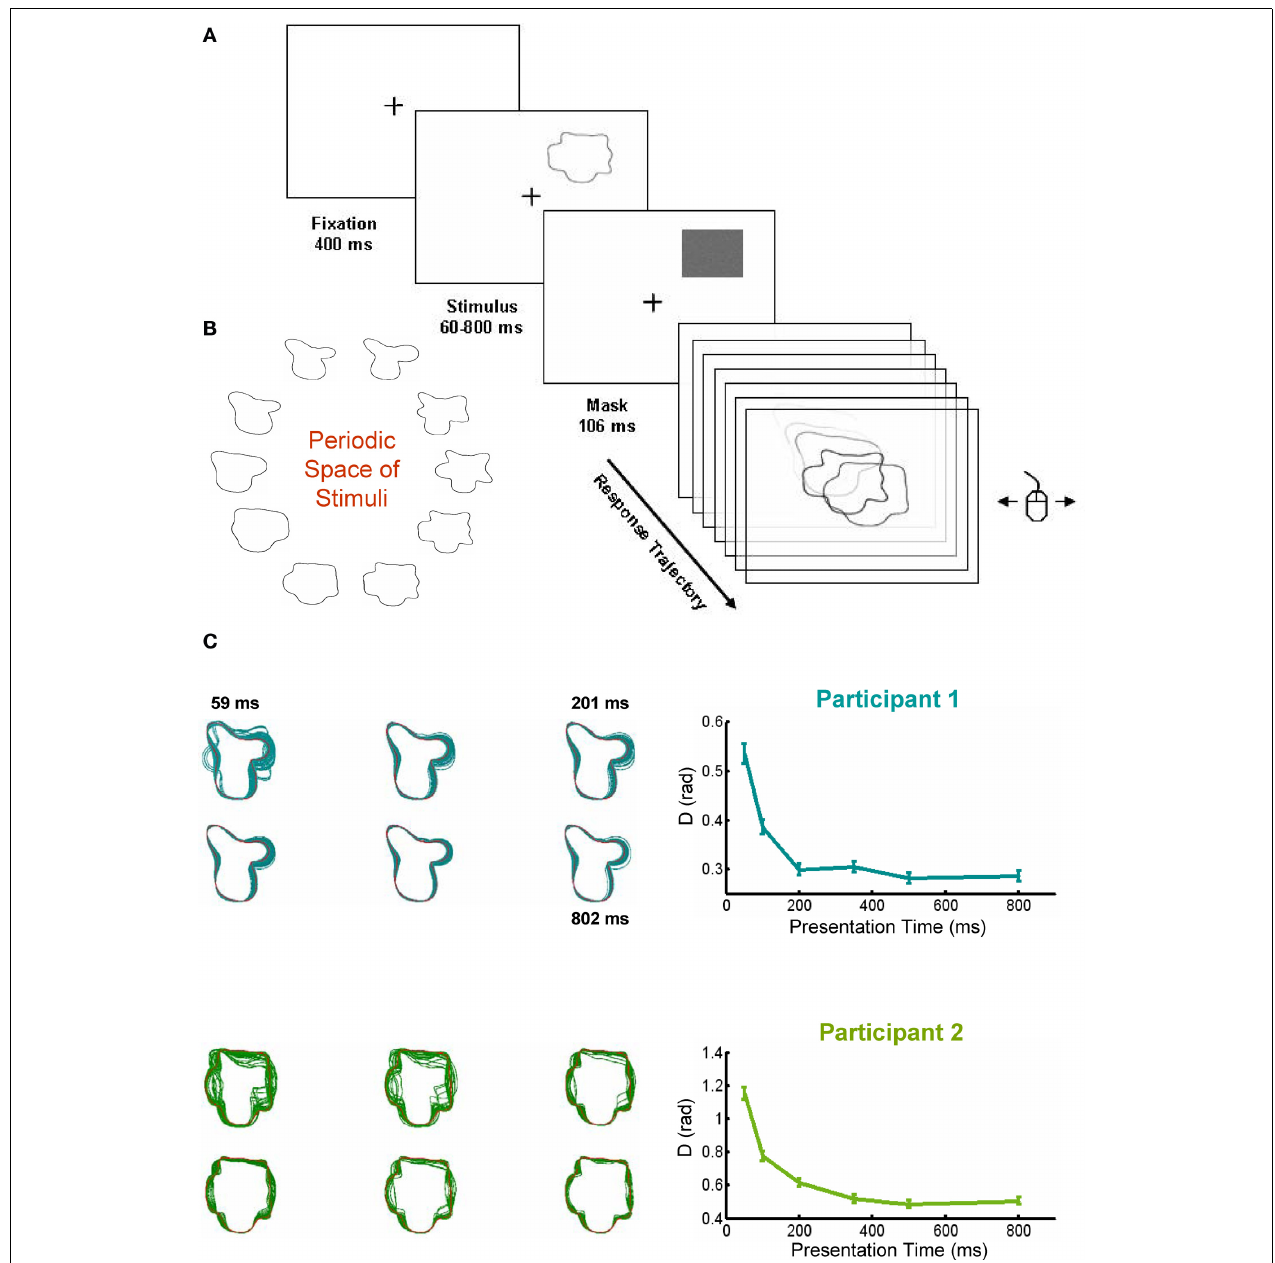
periodic shape space, showing the 10 stimuli. (C) Performance (the distance between the responded shape and the presented target) increased with presentation time. Left panels: visual superposition of all responded shapes for each target (only two shown, stimulus in red), Right panels: performance increased with presentation time, reaching an asymptote at around